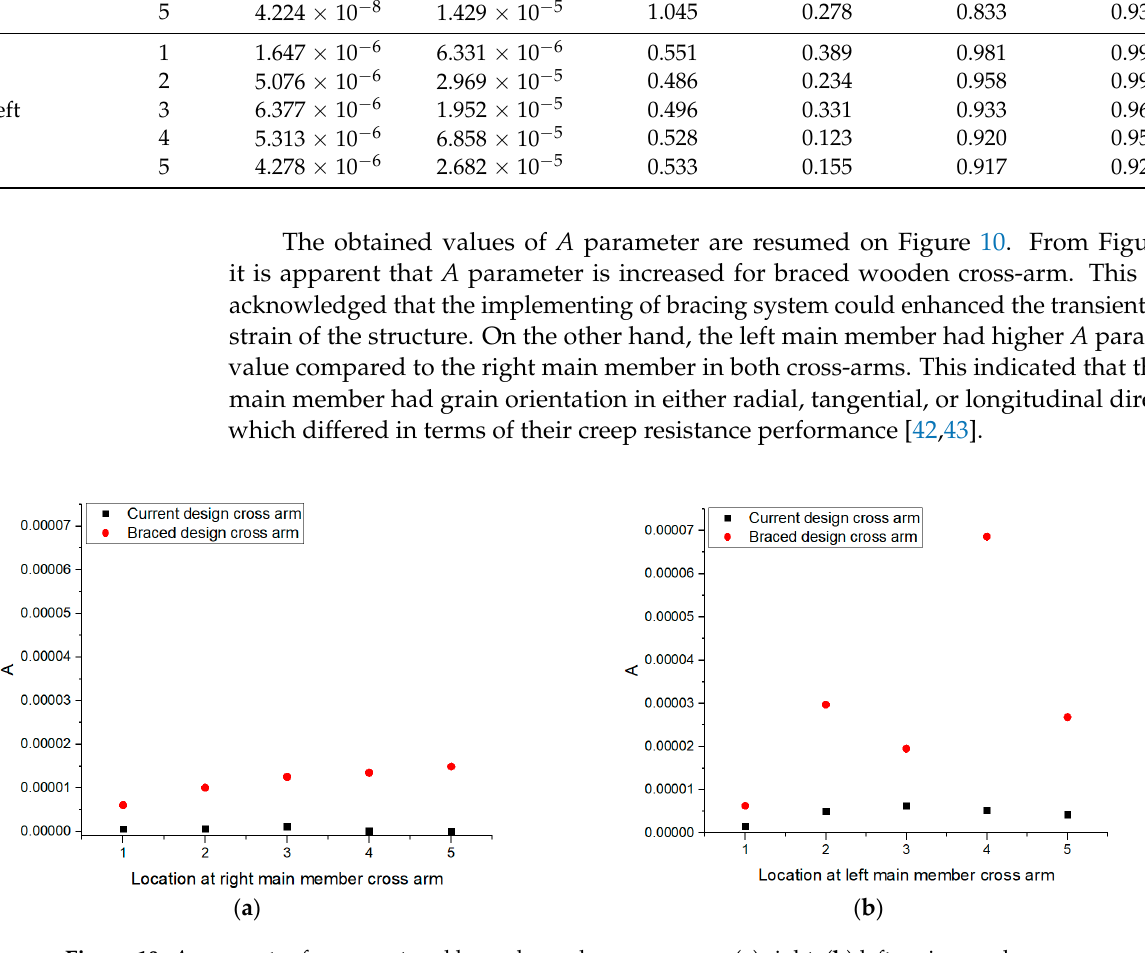
Figure 10. A parameter for current and braced wooden cross-arms: ( a ) right; ( b ) left main members